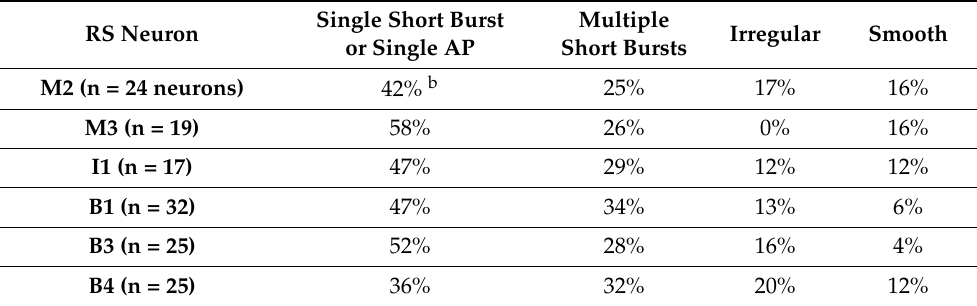
a—total of n = 142 injured (right) large, identified RS neurons (Müller cells; see text and Figure 1); N = 53 animals (note: insufficient n values for M1, I2-I4, B2, B5); some of the B cell from [28] were further analyzed and used for the present study. b—percentage of RS neurons with a particular firing pattern at intermediate current levels (see rationale in Section 3.3 of